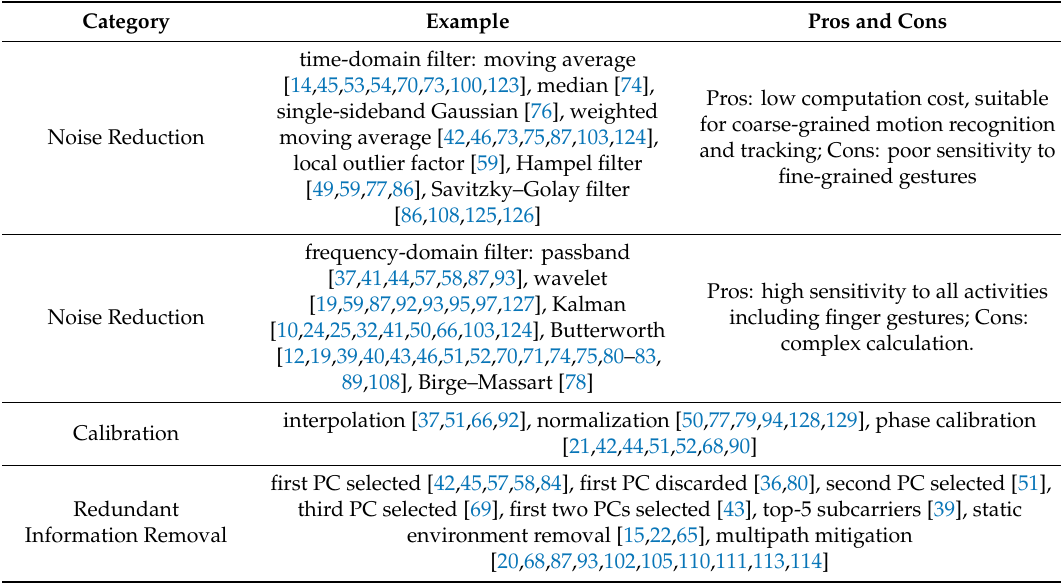
Table 5. Summary of signal